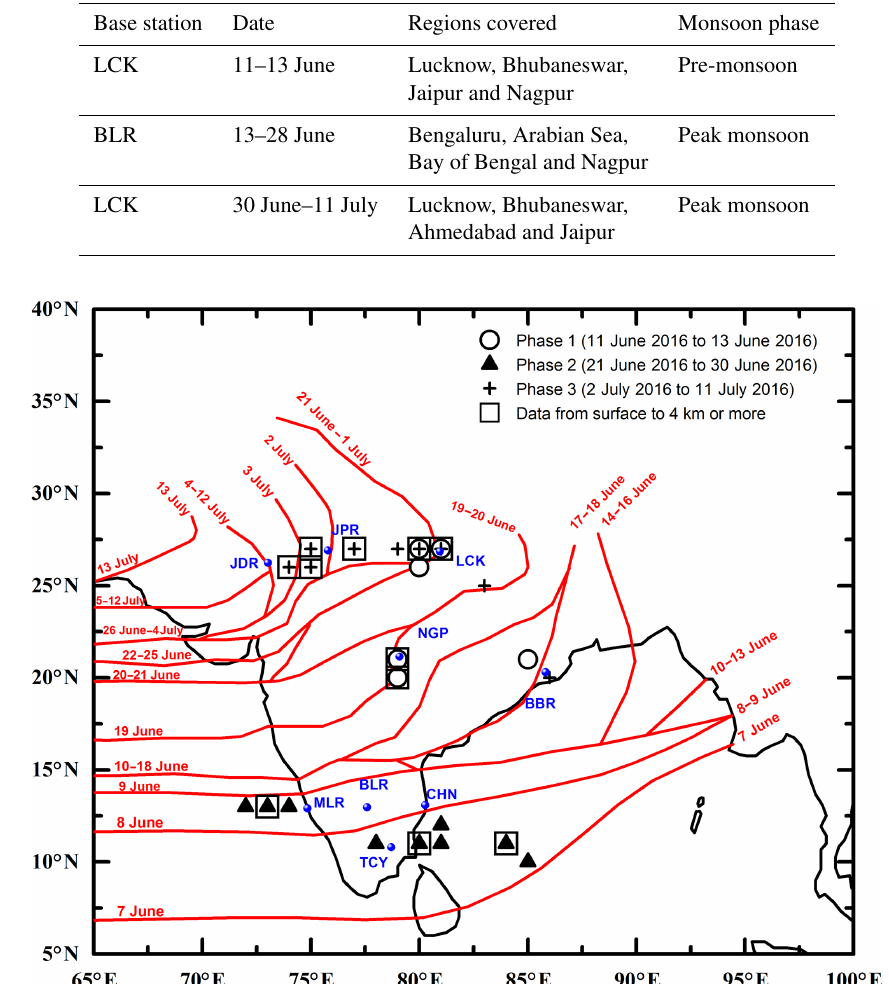
Figure 1. The locations corresponding to the vertical profiles are marked in the figure with the symbol indicating the phase of measurement. The locations where high altitude data are available are indicated by the big square. The red lines show the position of the monsoon trough on the dates of the year 2016 shown at the ends of the lines, taken from the India Meteorological Department website (https://metnet.imd. gov.in/imdnews/ar2016.pdf, last access: 30 January 2020) and is used to infer the phase of the monsoon (prior to onset, active, etc.) for the different